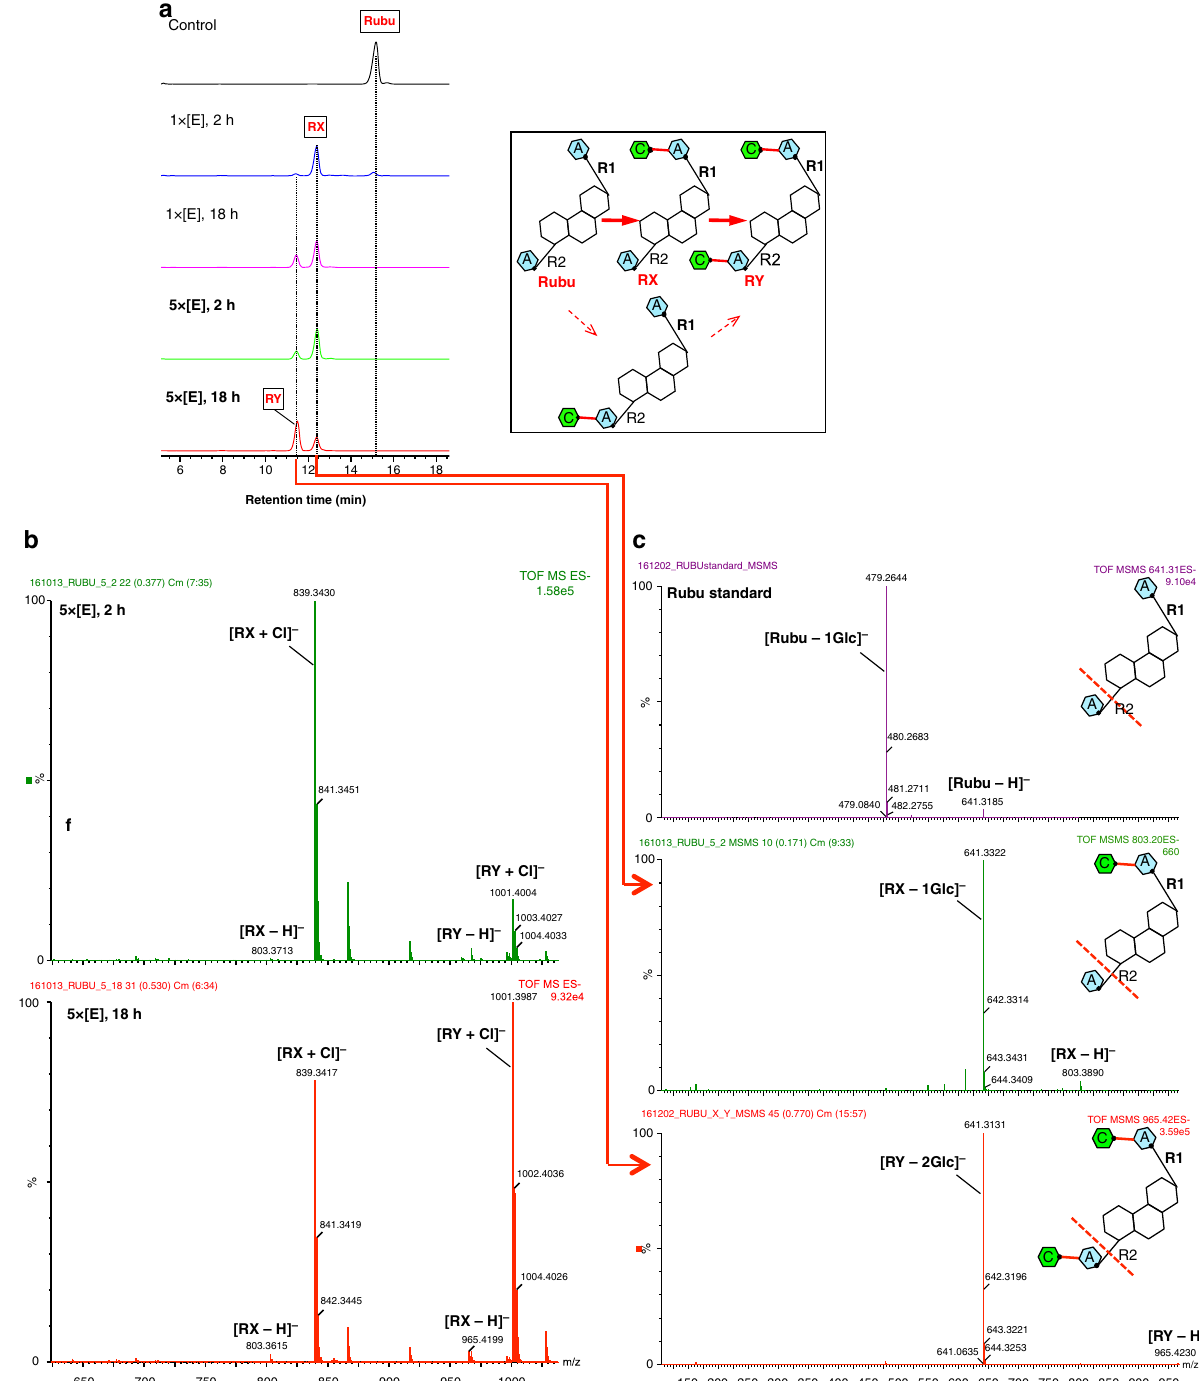
Fig. 3 Biochemical assays of two sugar transfers to Rubu by UGT76G1. a HPLC traces of the reactions of Rubu. The fi ve HPLC traces from top to bottom represent the same reaction conditions as Fig. 2. The fi rst product of Rubu is arbitrarily assigned as RX, and the second one is assigned as RY. The yields of the products are related to the enzyme concentration and the reaction duration. The reactions catalyzed by UGT76G1 are shown in the box. b Direct MS of two sugar transfers of Rubu by 0.15 mg ml − 1 UGT76G1 (5×) for 2 and 18 h. The two main negative ions derived from the products RX and RY are labeled and show the same characteristics in terms of the relative contents of the products as a function of the reaction duration as shown by HPLC (Fig. 3a). c MS/MS of the authentic Rubu standard and the collected HPLC peaks of the products RX and RY. The negative ions [Rubu – H] − , [RX – H] − , and [RY – H] − with m/z at 641.3, 803.4 and 965.4, respectively, were speci fi cally isolated as the parent ions and characterized by MS/MS. The most labile ester bond breaks fi rst, which was consistently indicated by the abundant fragment ions of Rubu, RX, and RY and was used to identify the positions of the added sugars transferred by UGT76G1. The inlet suggests where the ester bond breaks fi rst during MS/MS